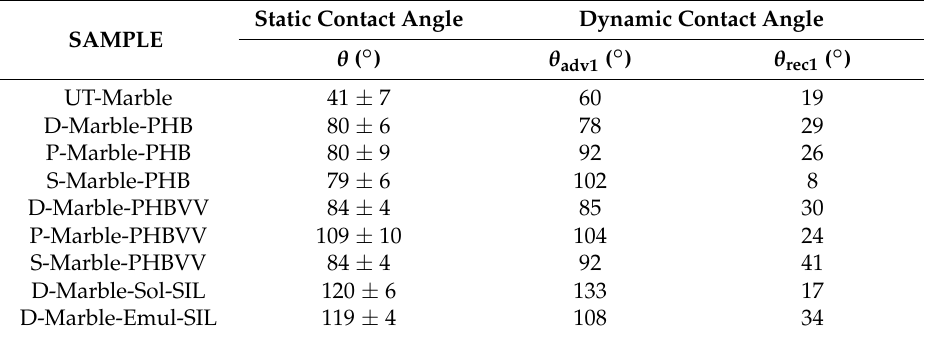
Table 7. Static contact angle ( θ ) and dynamic contact angles referred to the first immersion cycle ( θ adv1 , θ rec1 ) for untreated and treated